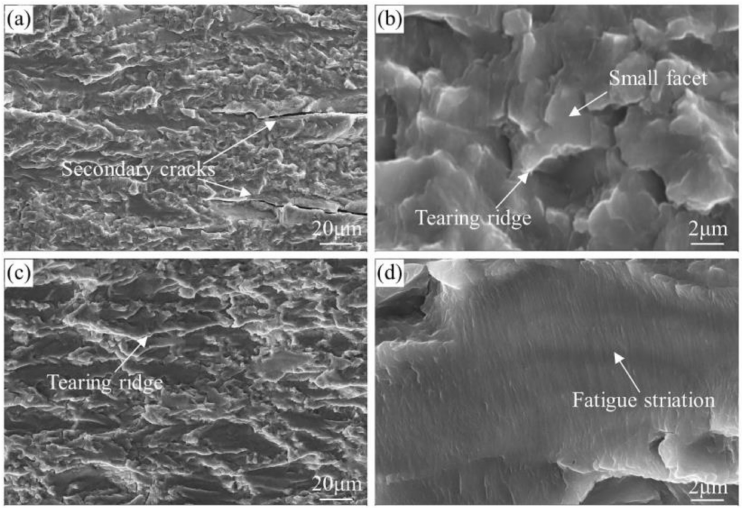
Figure 10. SEM fractographs characterizing the fatigue fracture surfaces of the under-aged alloy at ∆ K of about ( a , b ) 7 MPa · m 1 / 2 and ( c , d ) 15 MPa · m 1 / 2 .